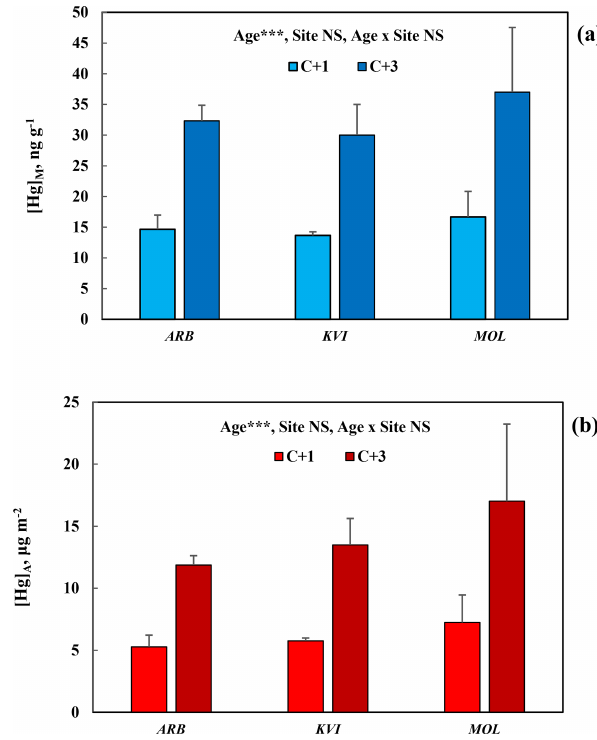
Figure 2. Mass-based [Hg] M (a) and area-based [Hg] A (b) in 1- year-old (C + 1) and 3-year-old (C + 3) needles of conifers ( Abies sachalinensis , Picea jezoensis , Pinus nigra , Cryptomeria japonica ) in the Gothenburg Botanical Garden Arboretum. Cryptomeria was not included in Fig. 2b because of the uncertainties in the SLA determination for this species. Error bars show standard deviation for the three trees sampled per species; ∗∗∗ p < 0 . 001; NS, non- significant.